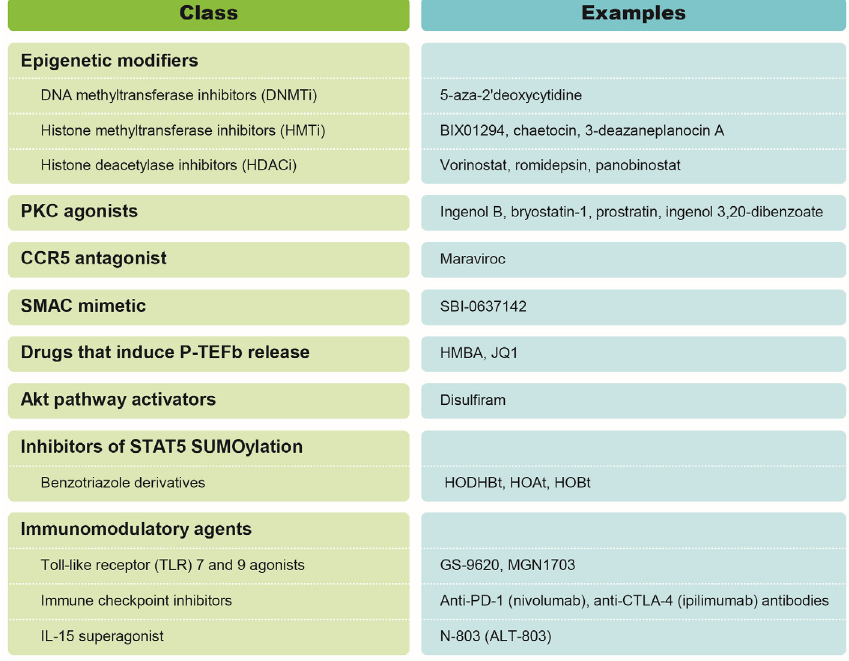
Figure 1. HIV-1 latency reversing agents.